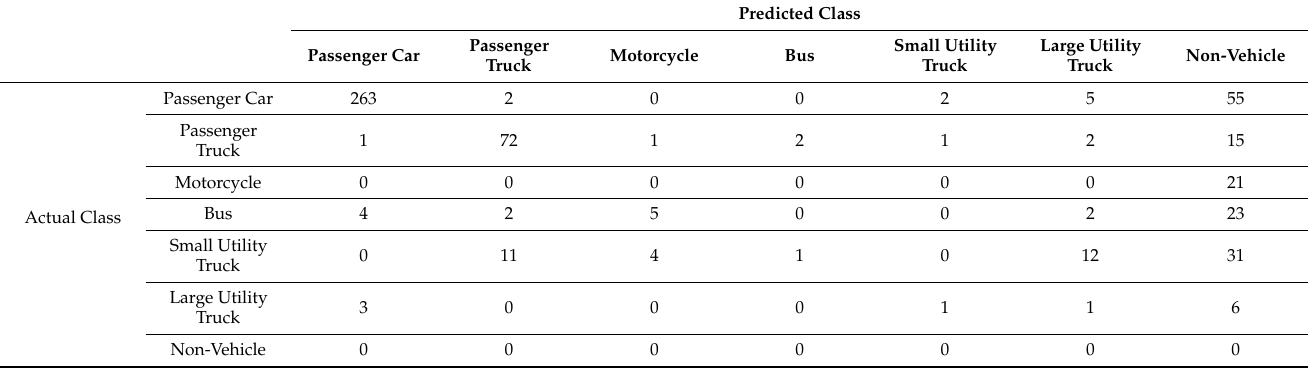
Table 16. Confusion matrix for multiple vehicle cluster detections for Video 3.